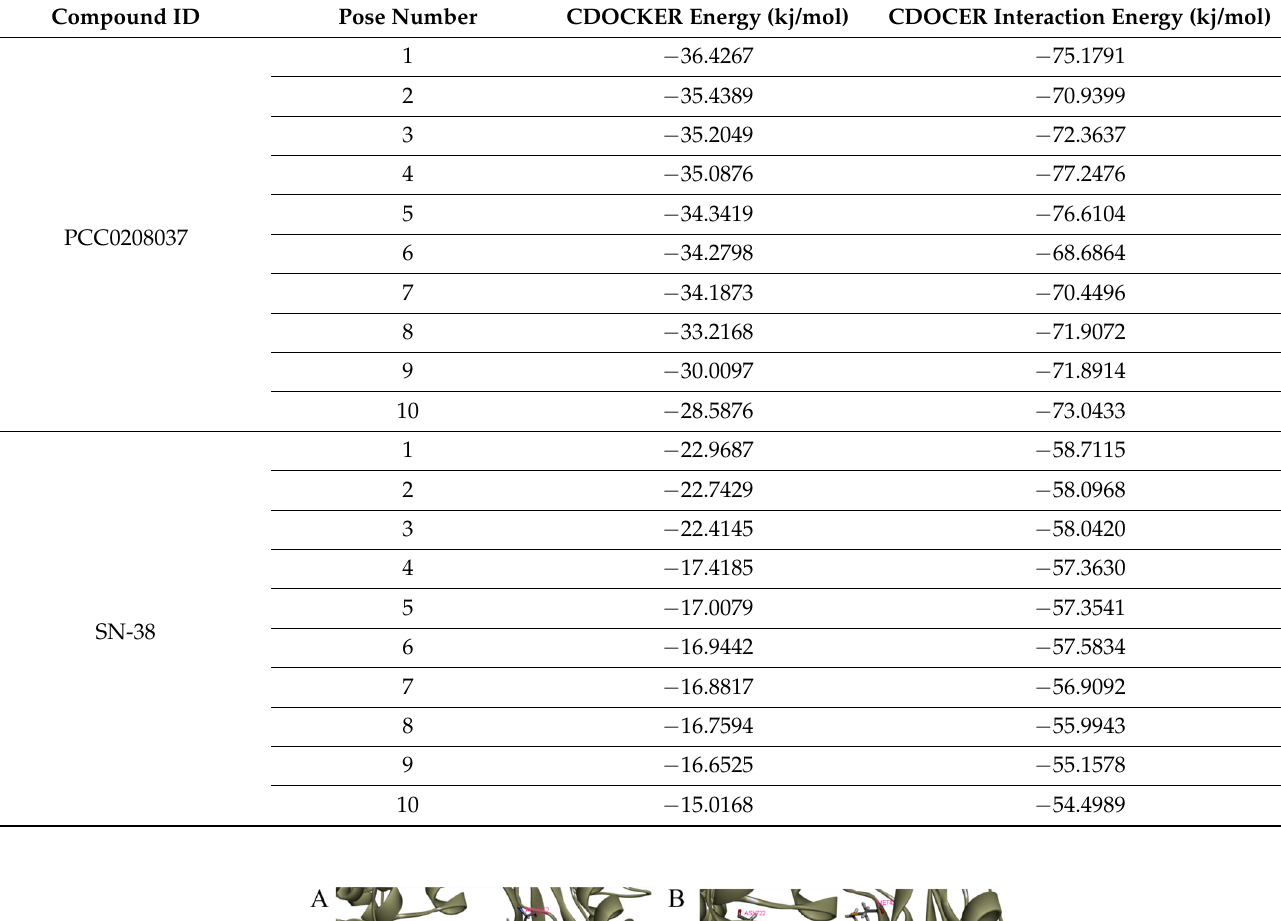
Table 2. The dock data of PCC0208037 and SN-38 utilized by the CDOCKER module of Discovery Studio.